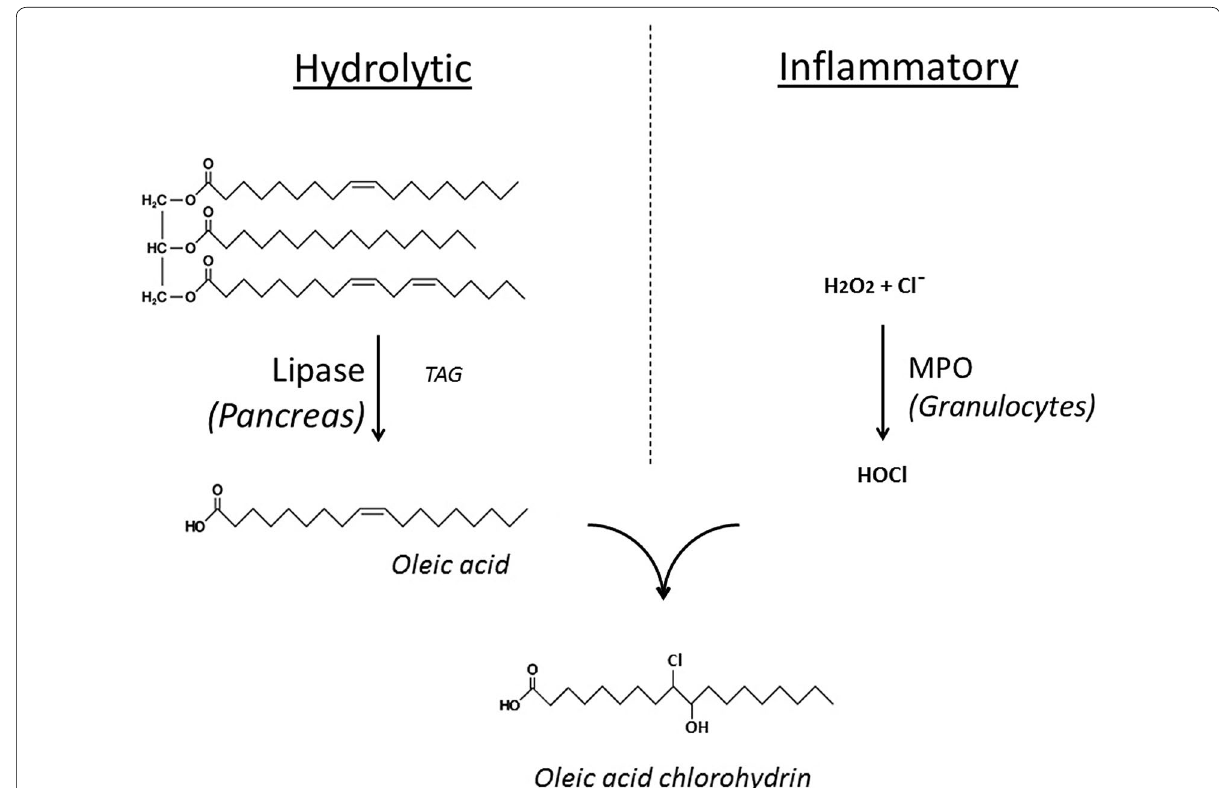
Fig. 1 Generation of oleic acid chlorohydrin in acute pancreatitis. TAG triacylglycerol; MPO